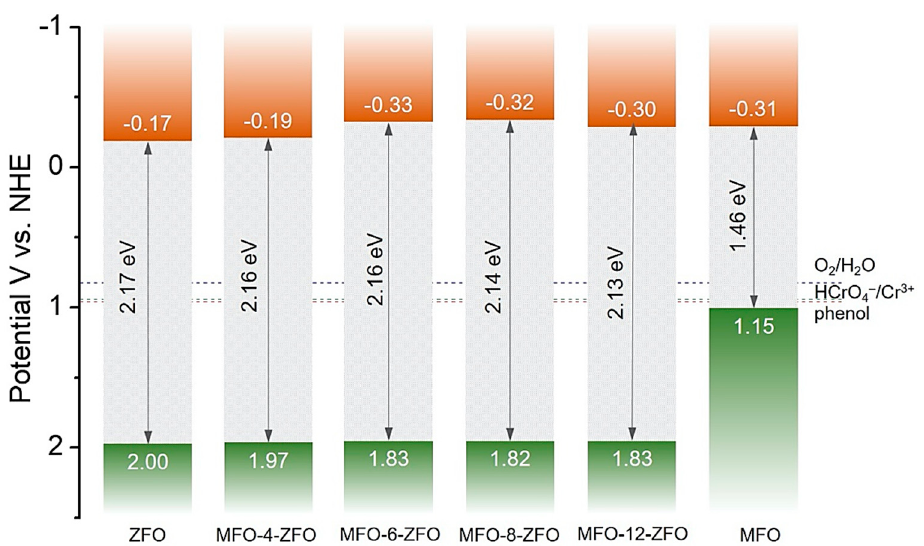
Figure 5. Energy band diagrams of ZFO, MFO, and MFO-ZFO MNAs catalysts. The redox potential levels of O 2 /H 2 O (0.82 V), HCrO 4– /Cr 3+ (0.94 V), and phenol (0.96 V) are also presented. All the potentials are given versus the NHE scale at pH = 7.